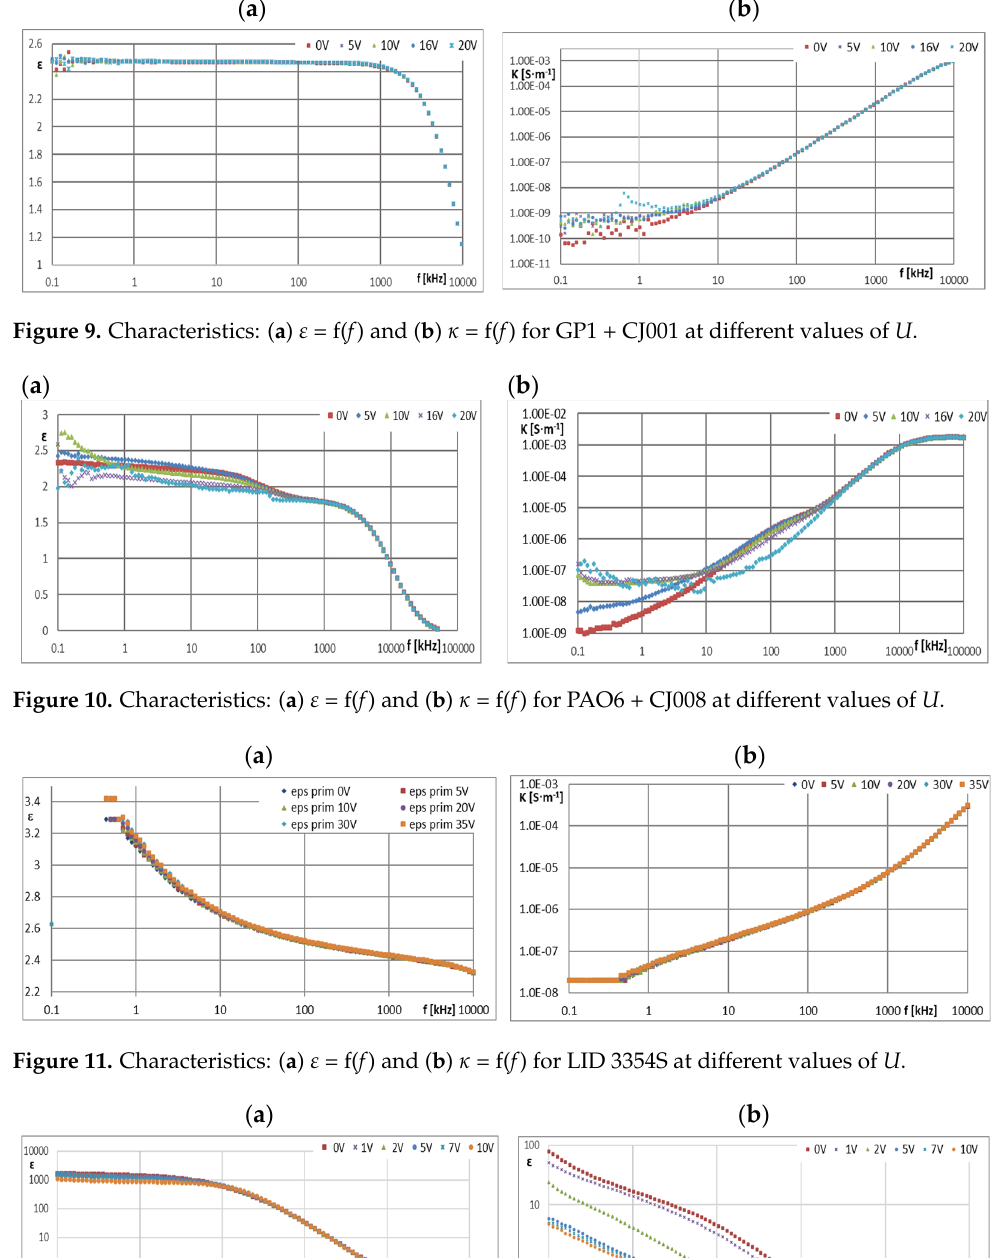
Figure 8. Characteristics: ( a ) ε = f( f ) and ( b ) κ = f( f ) for PAO6 at different values of U.